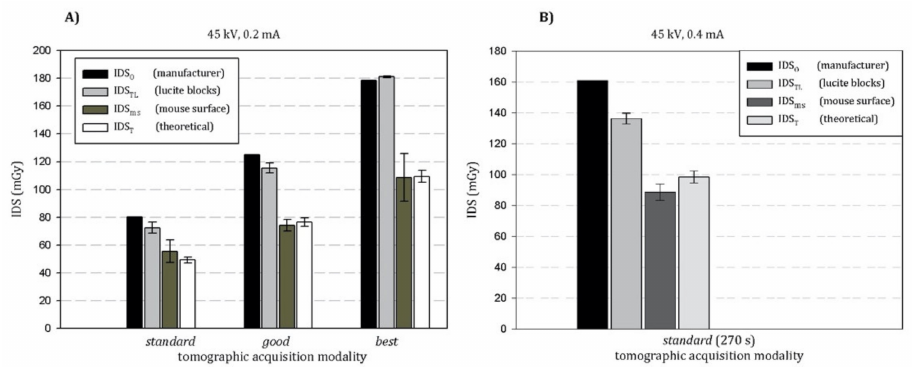
Figure 6. ( A ) Comparison of the imparted dose at surface (IDS) within the different microCT acquisition modalities. No statistical differences were observed between IDS 0 vs. IDS TL or IDS ms vs. IDS T . ( B ) Comparison of the imparted dose at surface (IDS) within the Standard